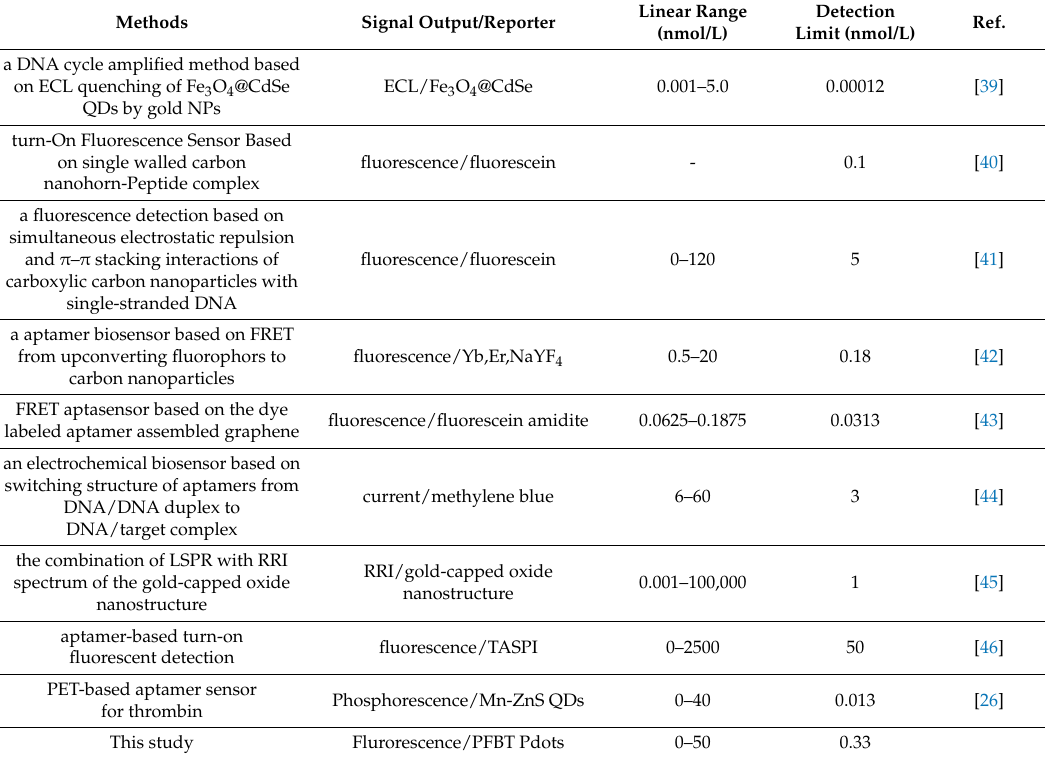
Table 1. Comparison of performances of aptamer-based sensors for thrombin detection. Methods Signal